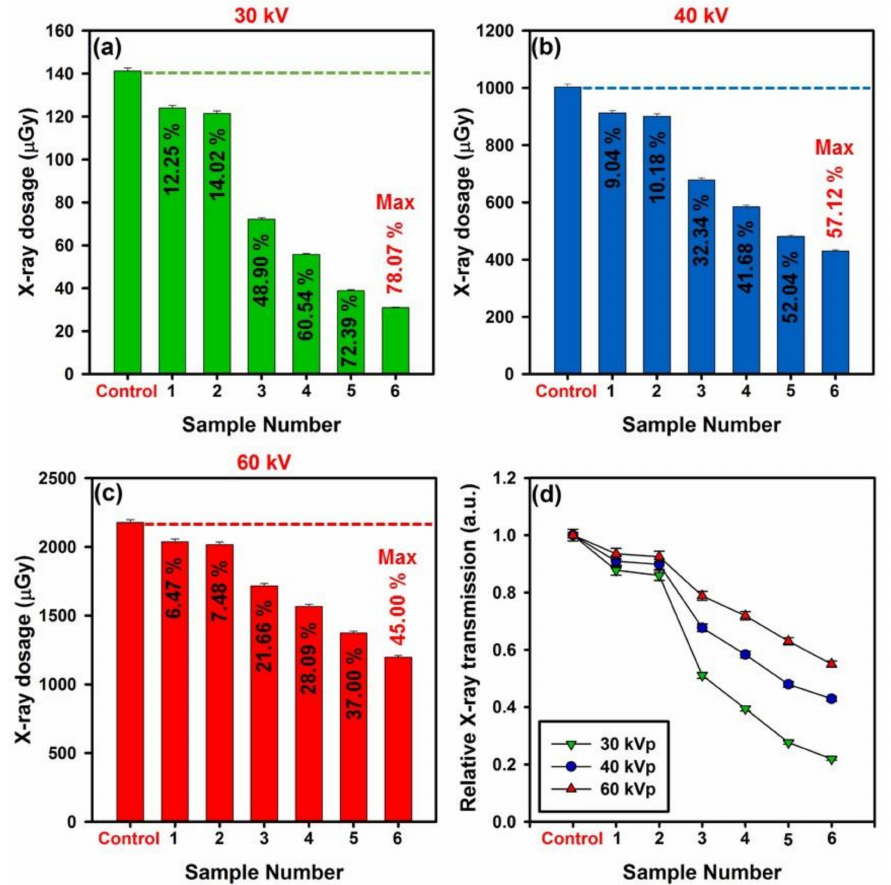
Figure 9. Overall rate of X-ray attenuation via the developed specimens at ( a ) 30 kVp, ( b ) 40 kVp, ( c ) 60 kVp X-ray tube voltages along with ( d ) relative X-ray transmission at diverse tube